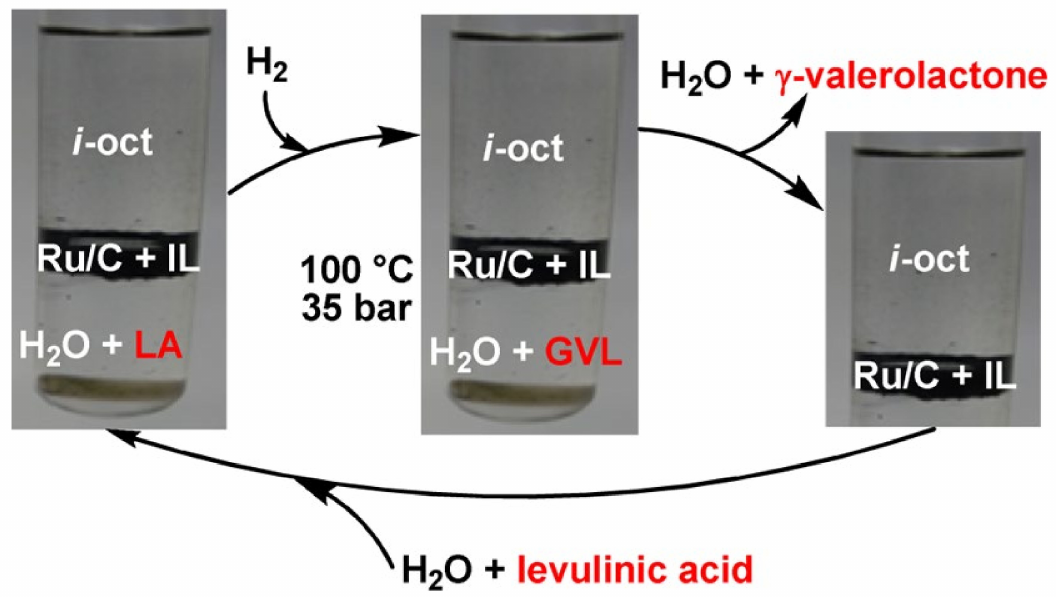
Figure 8. Pictures demonstrating the developed triphase catalytic system consisting of an aqueous phase, IL (confined Ru/C), and an organic phase. Reproduced from ref [107] with permission from American Chemical